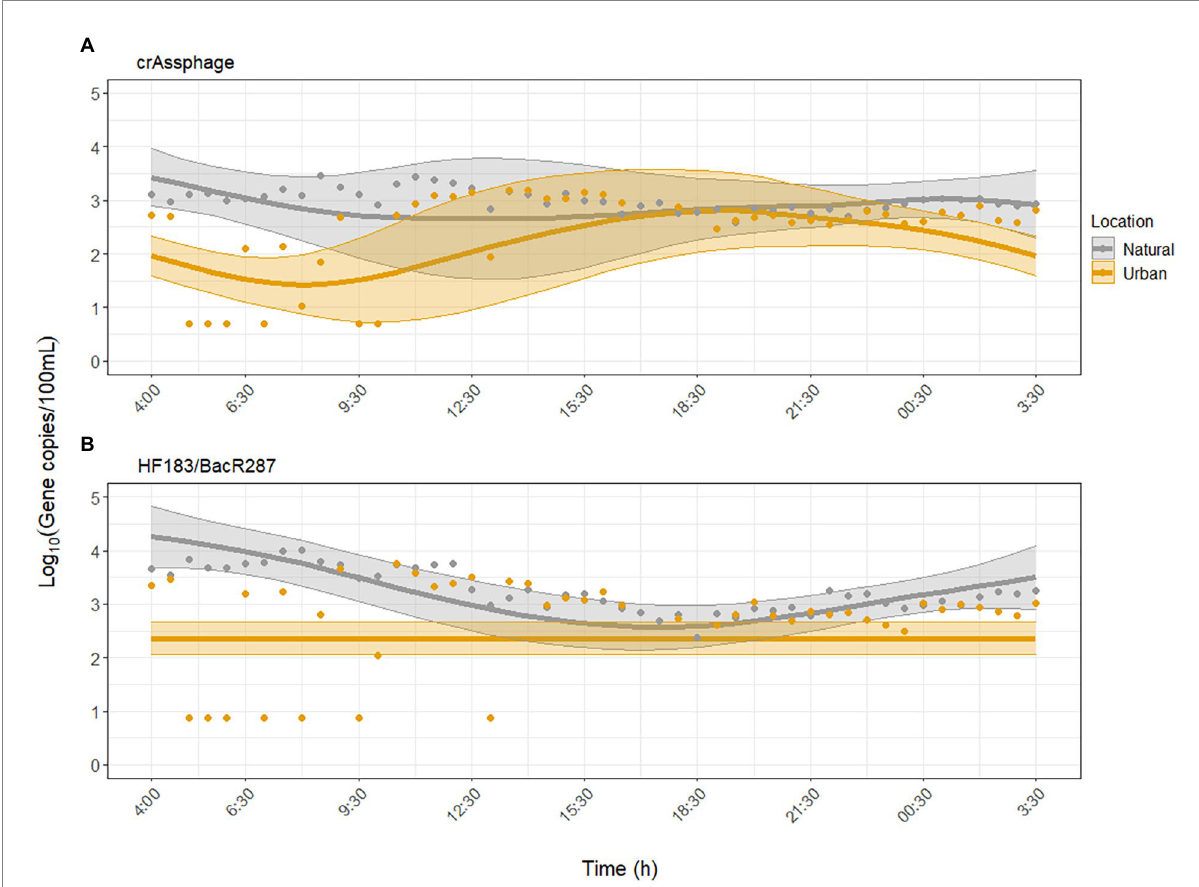
FIGURE 2 Dynamics of microbial source tracking markers (A) crAssphage and (B) HF183/BacR287 over the sampling period at the urban (Paces Ferry) and natural (Cochran Shoals) sites. Water temperature, pH, and turbidity were significant predictors of diurnal variability for both MST markers. Solid lines represent model predictions with 95% confidence intervals. Points represent all collected samples, with undetected samples set to half the limit of detection (LOD) for each